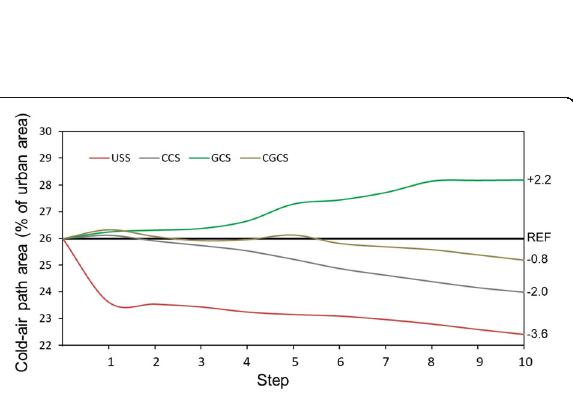
Fig. 5 Cold-air path area variation for the urban development scenarios in 10 steps of land-use modification (USS: Urban Sprawl Scenario, CCS: Compact City Scenario, GCS: Green City Scenario, CGCS: Compact Green City Scenario). The numbers on the right y- axis quantify total variation of cold-air path area at step 10 in comparison to REF (reference